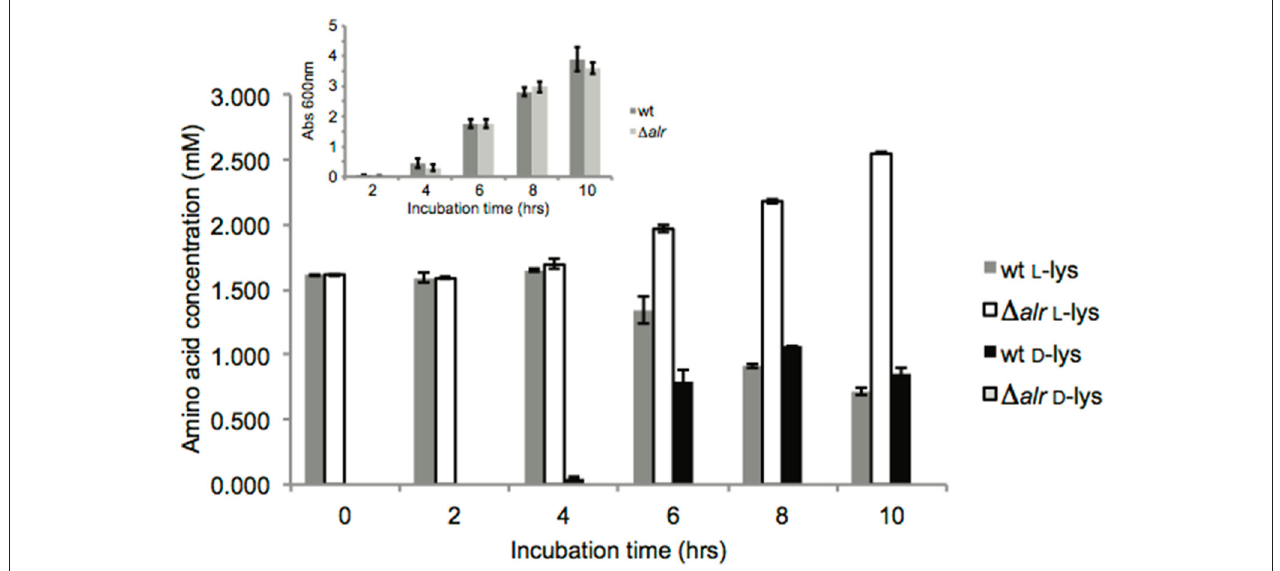
FIGURE 1 | Lys racemization in vivo . Average concentration values ± SD are the result of three biological replicates with three technical replicates each. Inset: growth measurements (OD 600 ) were performed on the same cultures. No statistically significant ( p > 0.05) OD 600 differences were found.